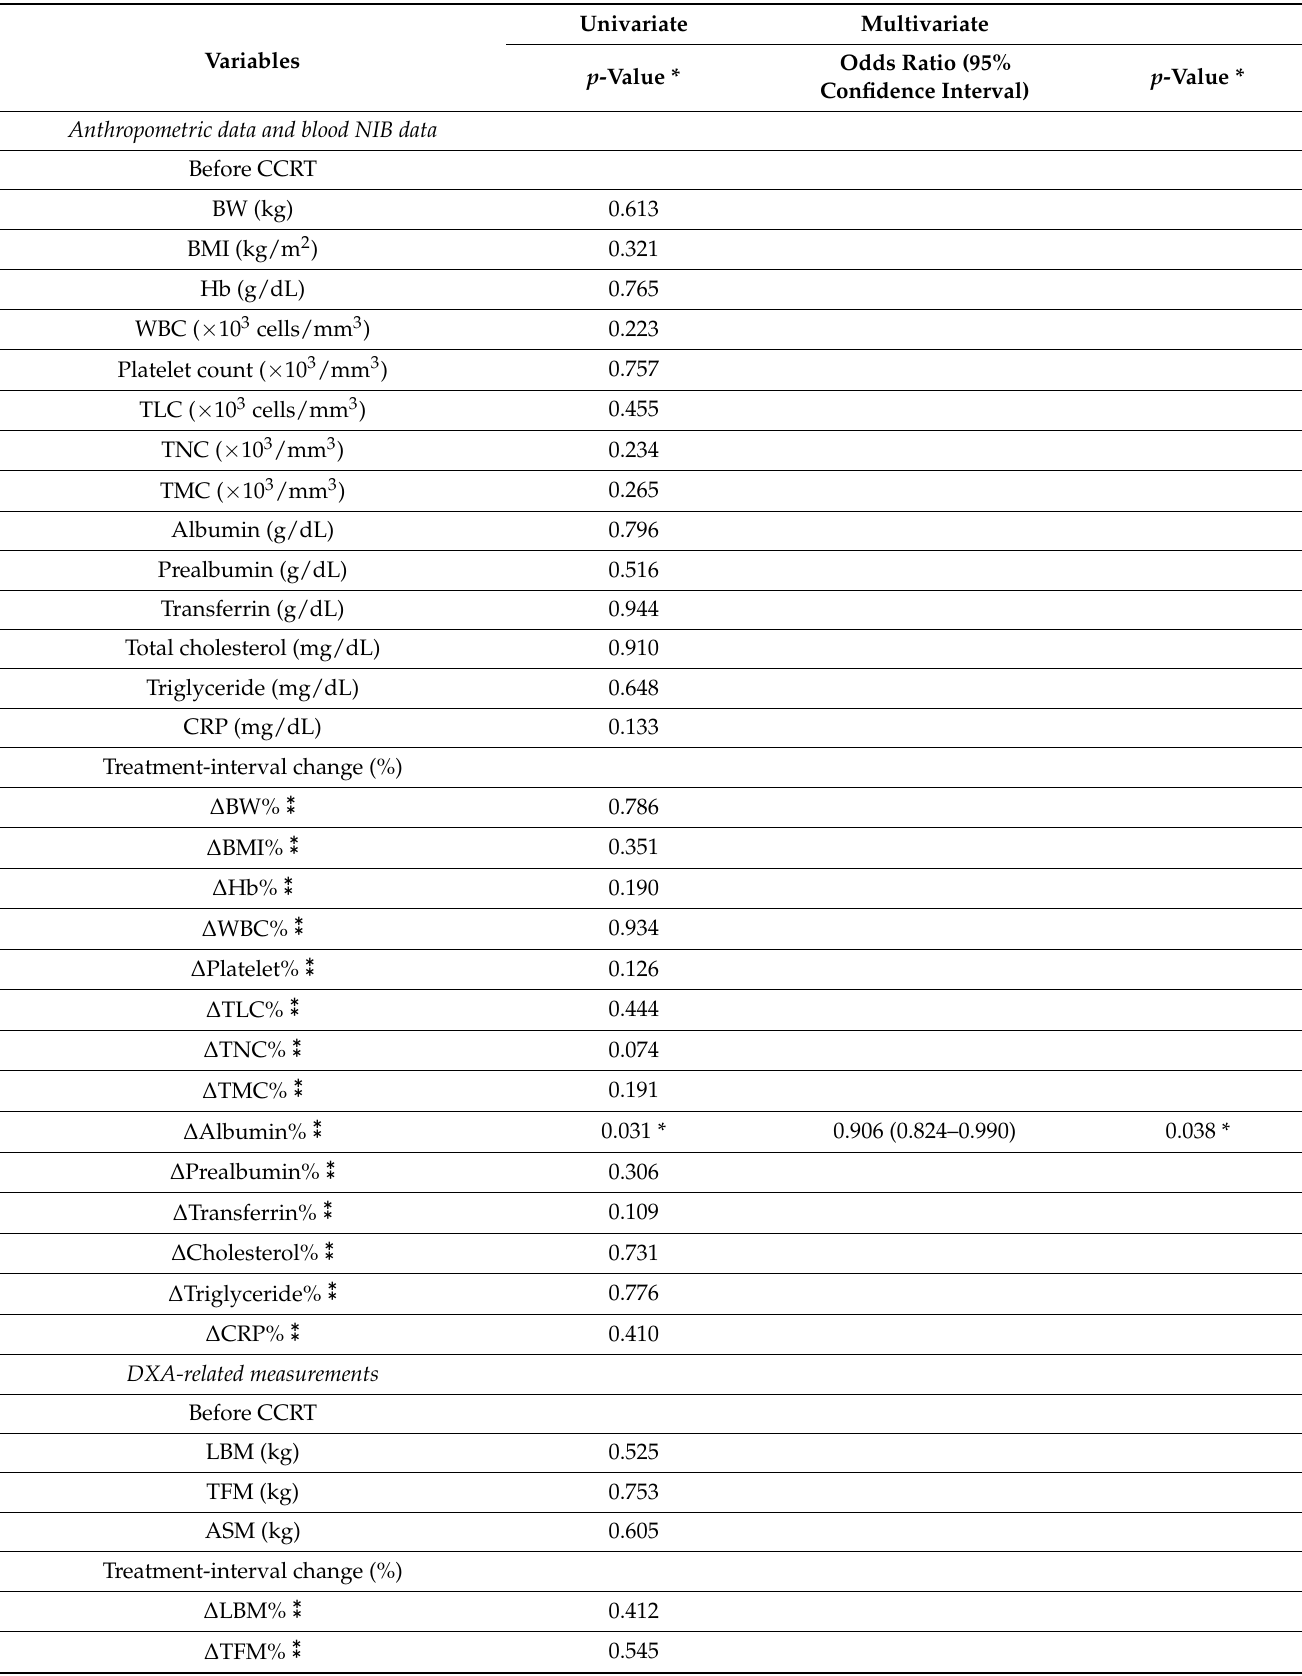
Table 1. Clinicopathological variables, biochemical and nutrition–inflammation data, anthropomet- ric and body composition characteristics, serum HLOP metabolites, and treatment-related factors of 44 patients with LAHNSCC completing the CCRT course, stratified by treatment interruption.